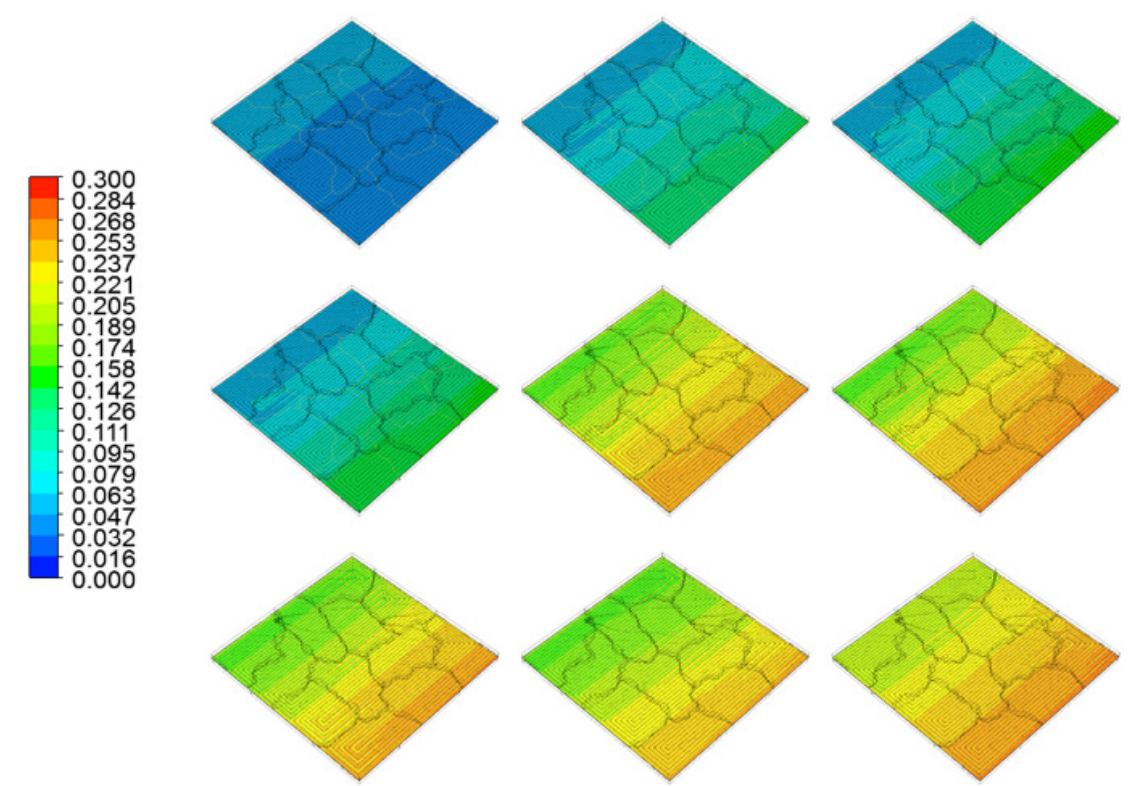
Figure 7. Anode catalyst layer hydrogen mass fraction history every 1 s, from 1 ( top left ) to 9 s ( bottom right ). Anode inlet left corner, anode outlet right corner.